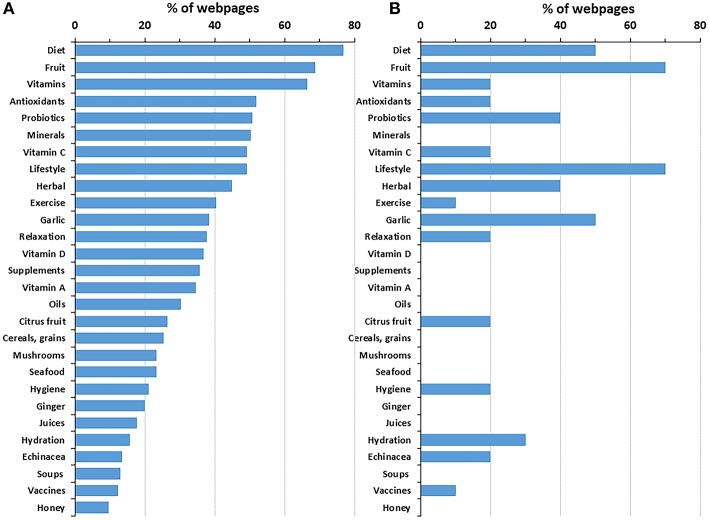
Content analysis of the whole SERP (A) and the top-10 webpages (B). Data show the percentage of webpages (A, n = 185; B, n = 10) mentioning a specific approach in the context of boosting immunity. Only the approaches that were mentioned in at least 10% of total webpages are shown.